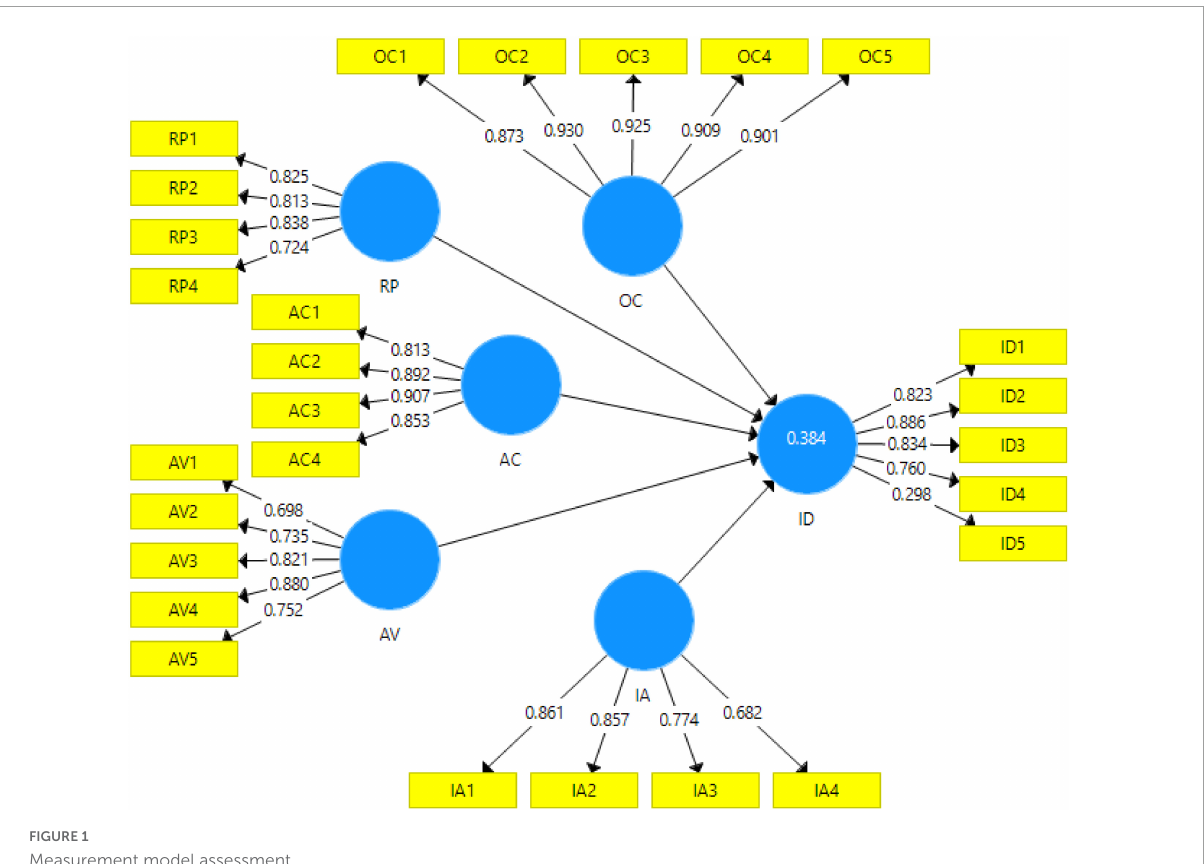
FIGURE1 Measurement model assessment.